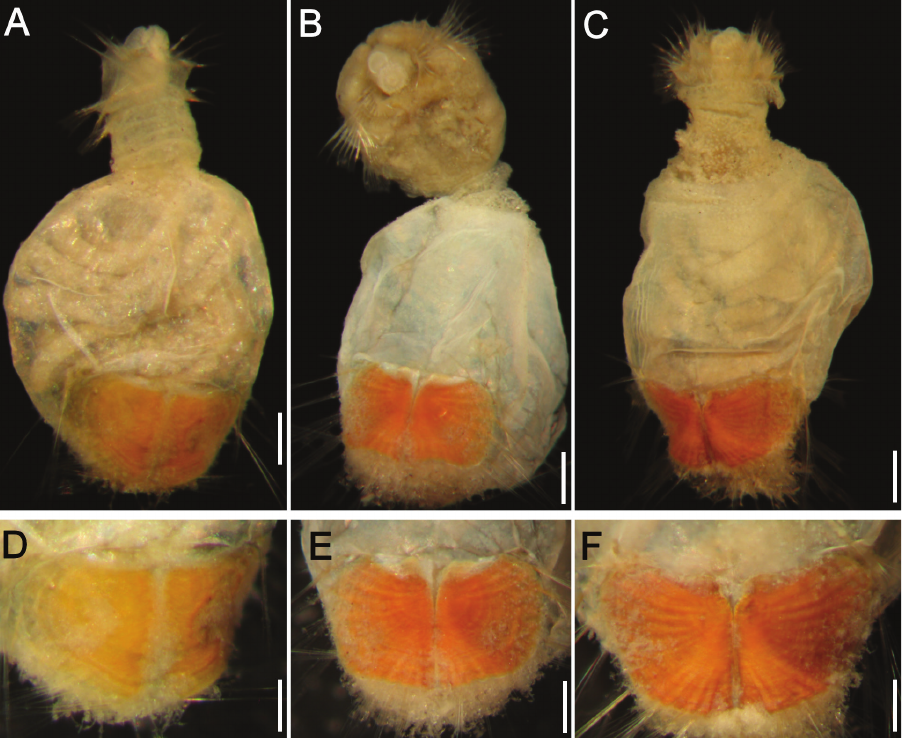
Figure 6. Sternaspis maureri sp. n., non-type specimens (Sta. 94 LACM 0000) A – C Ventral view of complete specimens D – F Ventro-caudal shields of the corresponding specimens. Bars A 0.2 mm B 2.2 mm C 0.6 mm D 0.15 mm E 0.3 mm F 0.4